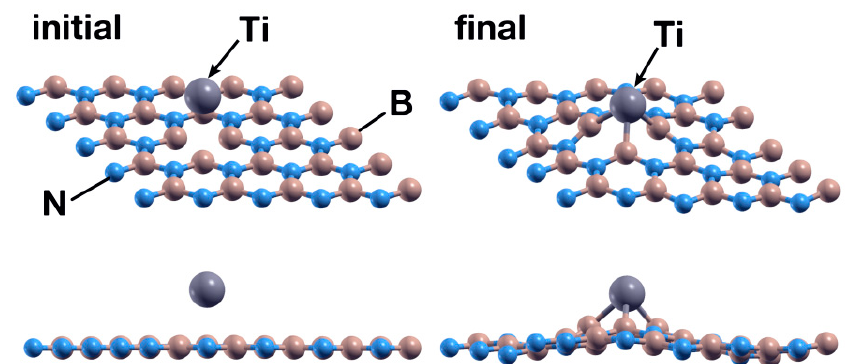
Figure 12. Initial ( left ) and final ( right ) configurations of the FPMD calculation for the second case considered. The upper images show a perspective view of the system, while the lower images show the XZ plane. The titanium atom chemisorbs in the hBN surface with an N vacancy, occupying the vacancy site.